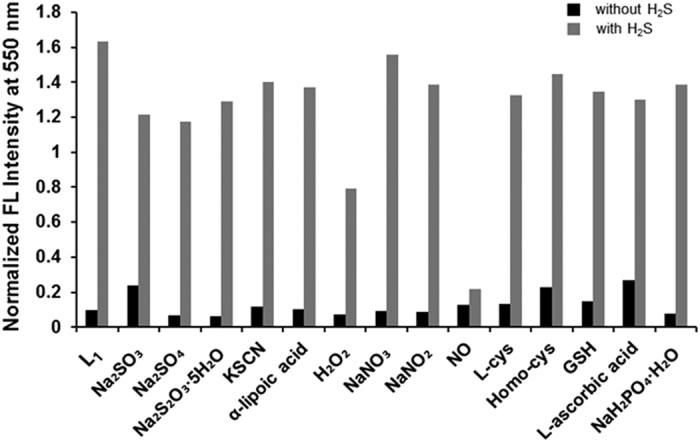
Fluorescence responses of L1
(10 μM) toward sulfur-containing inorganic ions
(S2O3−,
SO42−,
SO32−,
SCN−, 1 mM), inorganic salt
(NaH2PO4, 1 mM), organosulfur compound
(α-lipoic acid), reactive oxygen species
(H2O2, 1 mM), reactive nitrogen
species (NO, NO3, NO2, 1 mM), thiols
(L-cys, homo-cys, glutathione 1 mM), L-ascorbic acid
(1 mM) and NaHS (100 μM) in PBS buffer
(pH 7.4) at 37 °C for 60 min. Excitation
at 435 nm.